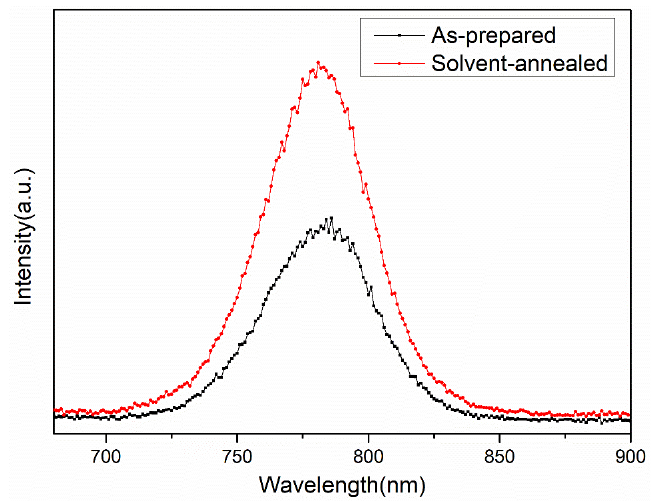
Figure 6. Photoluminescence (PL) spectra of CH 3 NH 3 PbI 3 films with and without solvent annealing.